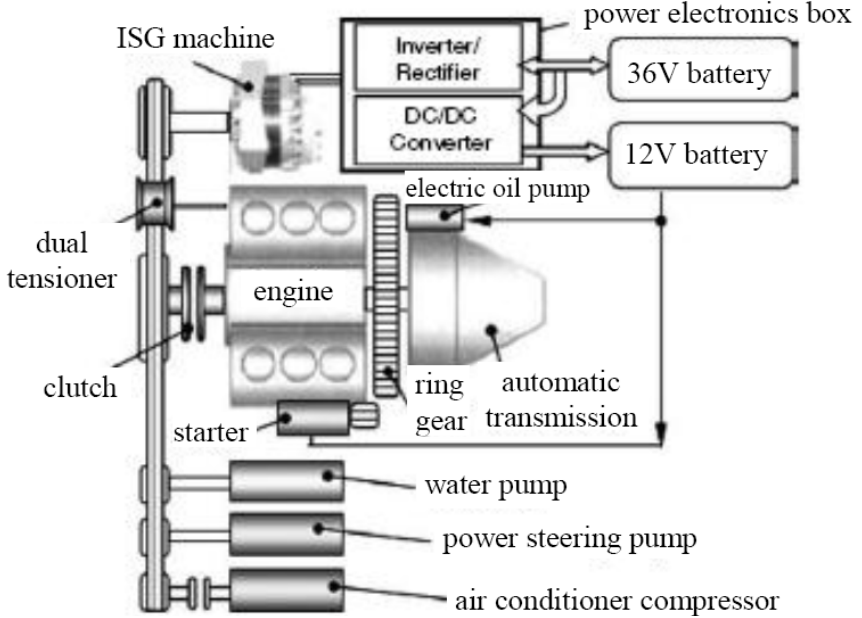
Figure 2. Layout of a typical B-ISG system